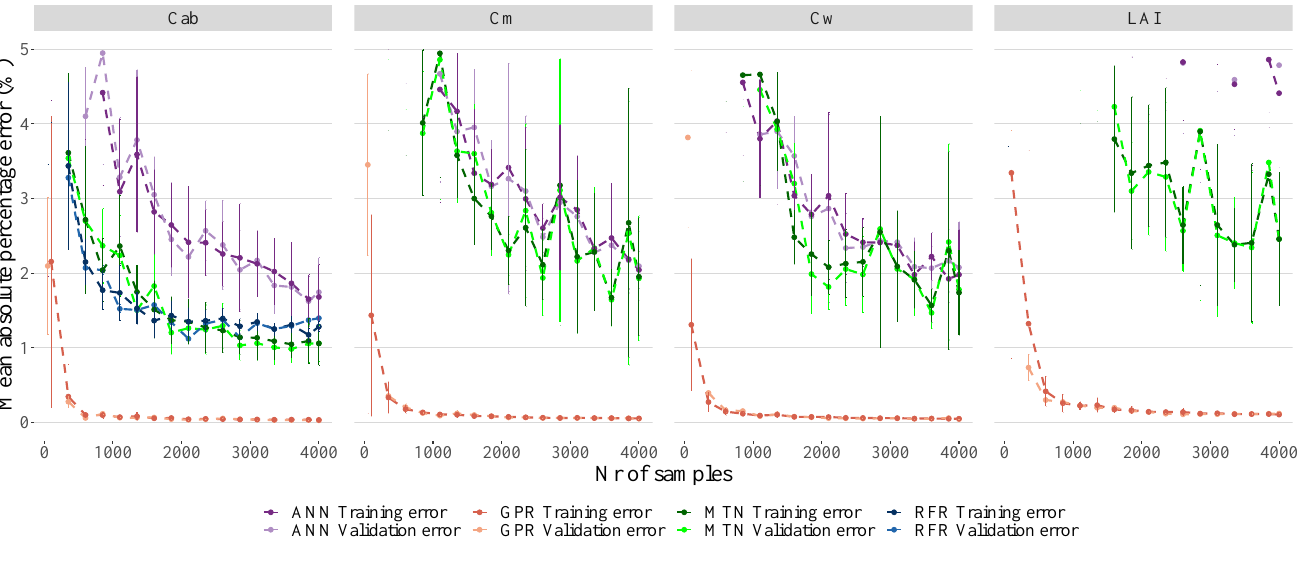
Figure 7. Detail of Figure 6 between 0 and 5%. While most models produced errors below 2.5% on C ab , the RFR was the worst overall model by being unable to properly predict C m or C w , and not being able to predict LAI with less than 10% error (Figure 7). The GSA analysis showed that these three biophysical variables are likely correlated and interacting (see Table 3 and Figure 5) and thus RFR was not able to address this effect. MTN outperformed ANN both in terms of the MAPE error as well as in terms of the number of samples necessary for accurate